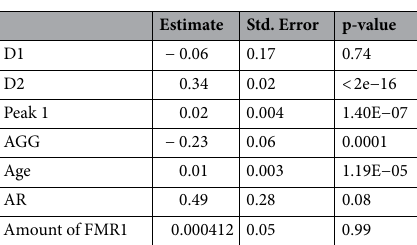
Estimate Std. Error